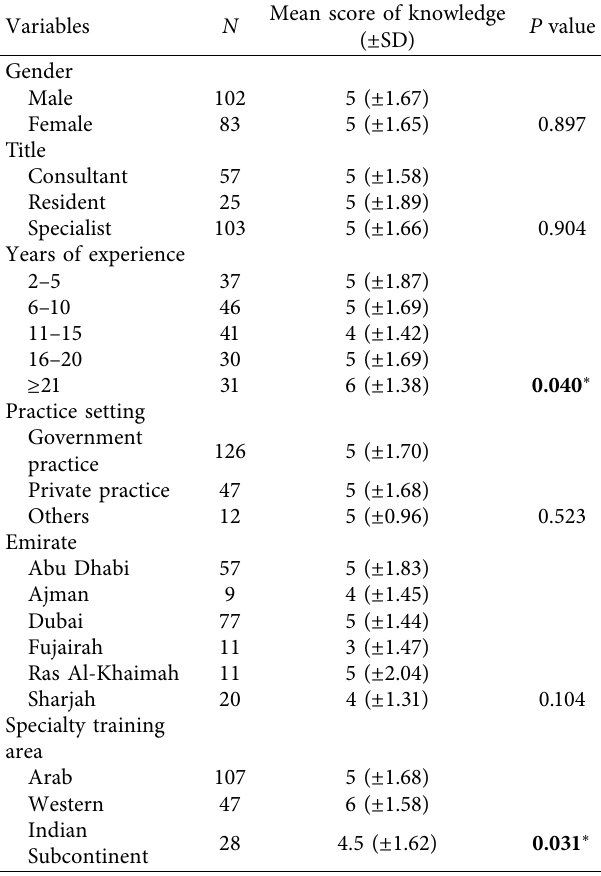
Table 3: Correlation between the score of knowledge and paedi- atricians’